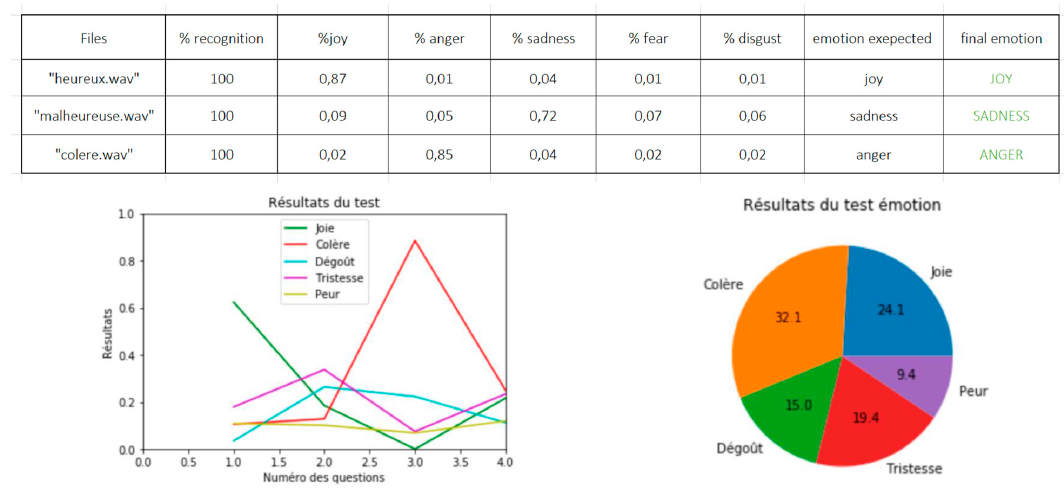
Figure 4. Results including the IBM Watson analyzer. The table (top) shows the results of three answers (audio files in French) according to the emotion score produced by the analyzer, the WEB Jupyter interface shows the evolution of the scores by the number of answers (bottom left screenshot) and the score graph for the answers set (bottom right screenshot). Note: the screenshot of the WEB interface shows the graphic and circular views in the language chosen by the specialist (therefore automatically translated by the tool into French).